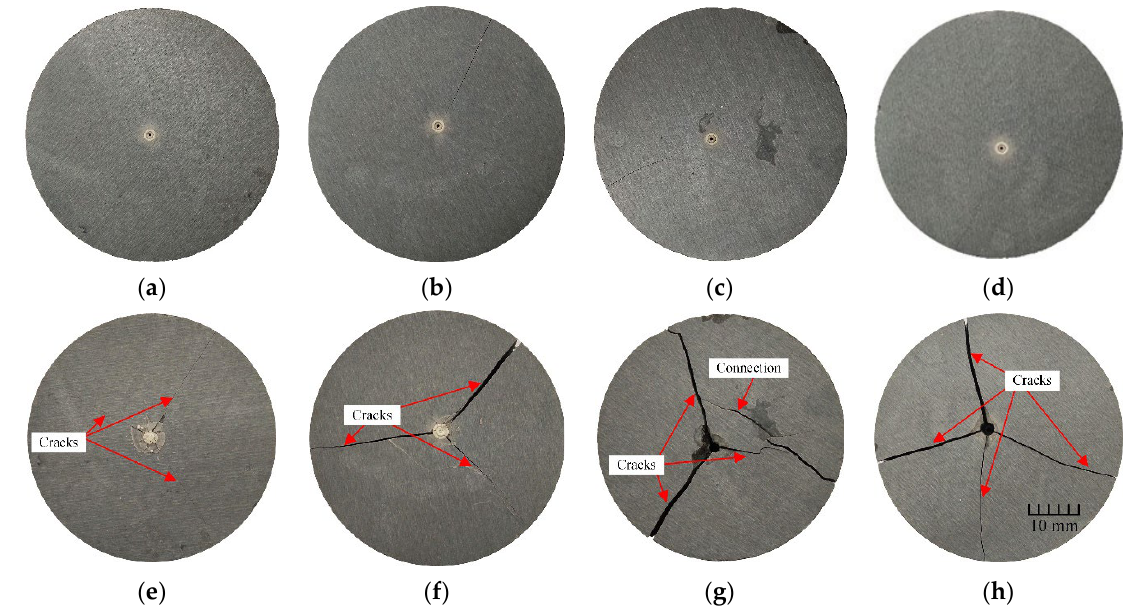
Figure 11. Surface morphology of dried sample after laser irradiation at a power of 135 W: ( a ) 90 s; ( b ) 120 s; ( c ) 150 s; ( d ) 180 s; ( e ) 90 s after one month; ( f ) 120 s after one month; ( g ) 150 s after one month; and ( h ) 180 s after one month.